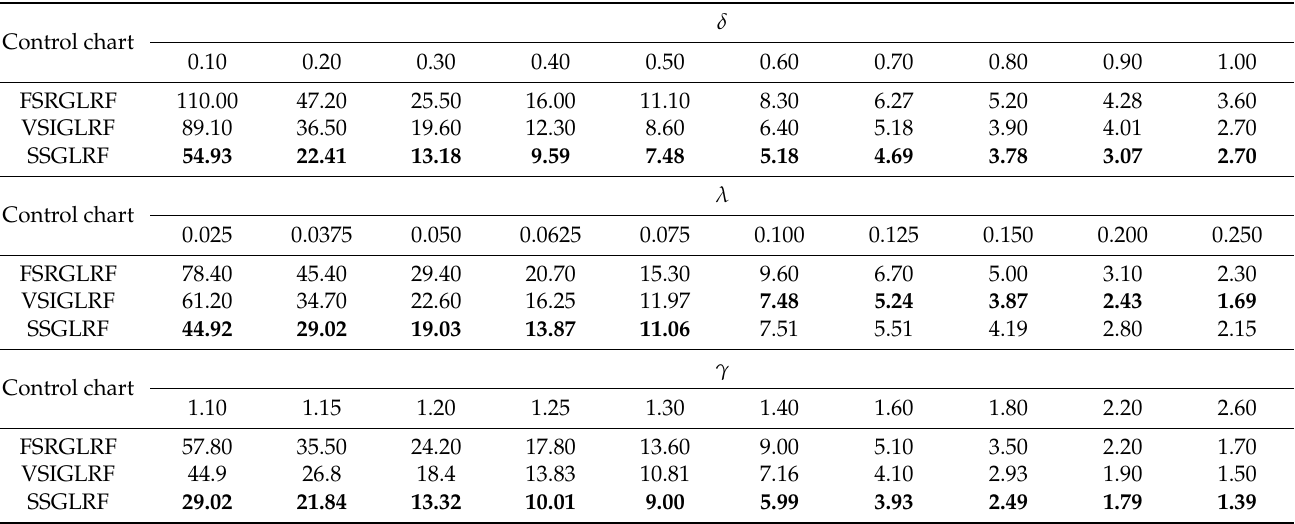
Table 5. The ATS 1 values for the FSRGLRF, VSIGLRF, and SSGLRF control charts under the shifts in intercept, slope, and standard deviations when there are fixed explanatory variables ( m = 400 and ATS 0 =